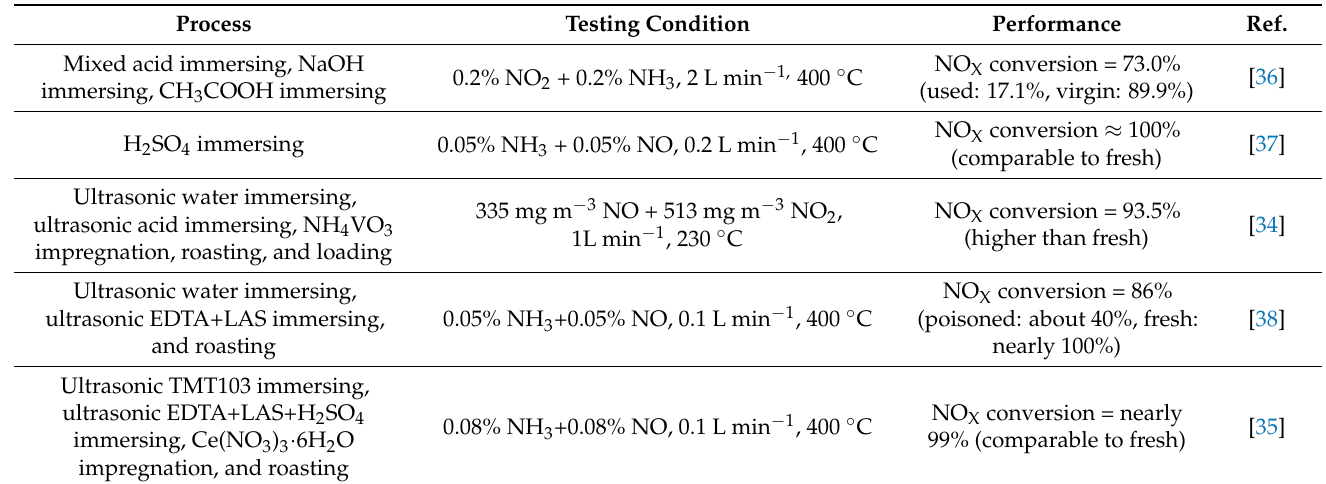
Table 1. Regeneration process for SCR